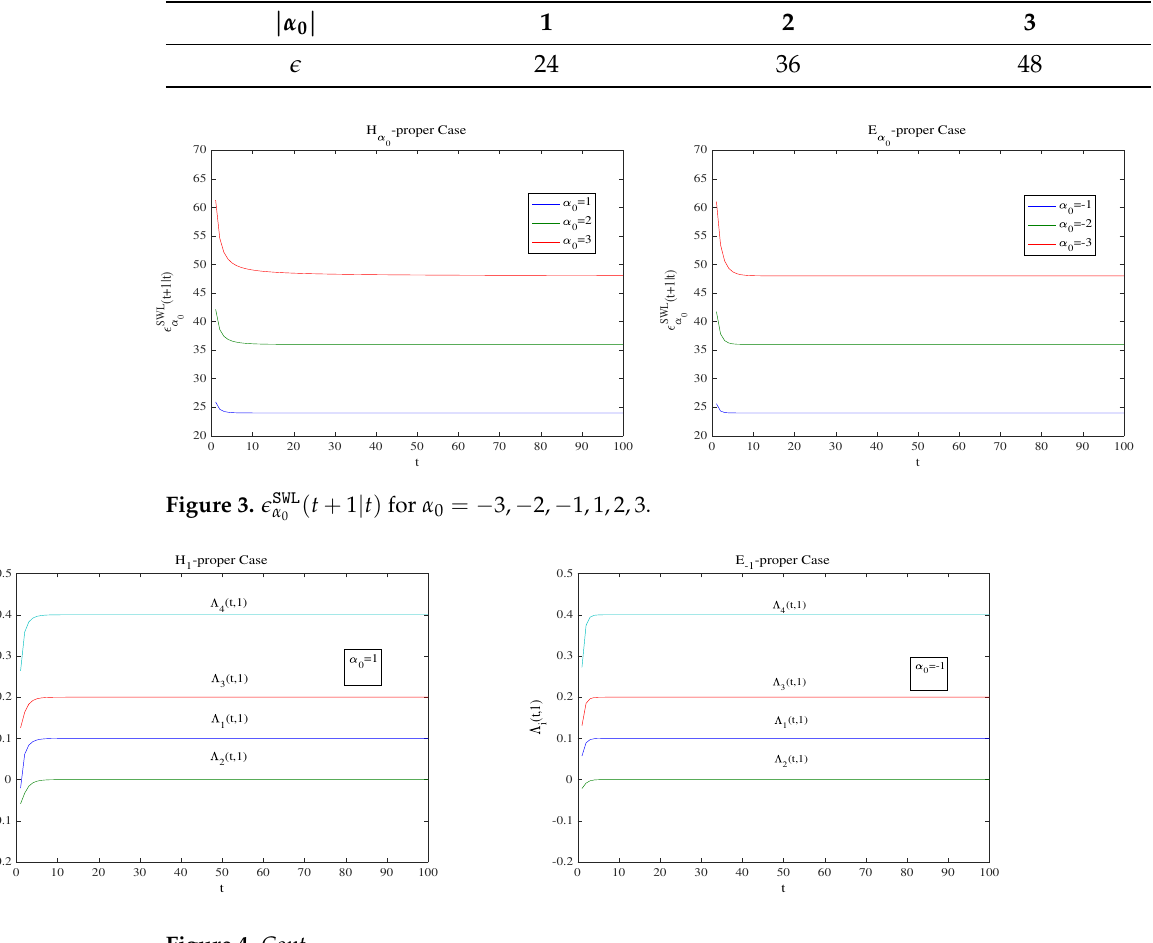
Table 4. Steady-state errors of the one-stage predictor for the different values of α 0 .